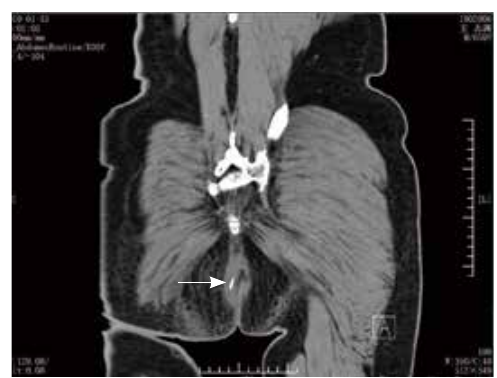
Figure 7 CT image on the coronal scan shown a high-density line-like lesion (arrow) in the abscess consistent with a chicken bone.